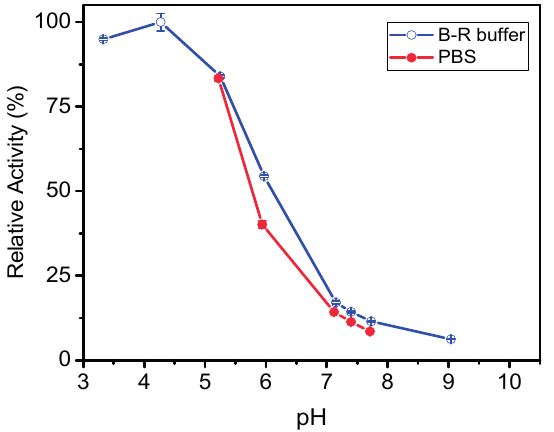
Figure 2. Relative activity of β -galactosidase as a function of pH in Britton-Robinson (B-R) and phosphate (PBS) buffers. The enzyme activity was assessed by applying the correction for absorbance (420 nm) resulting from the effect of pH on the extinction coefficient of ONP (see Figure 1b). Activity in pH 7.15 B-R buffer is used as reference. Lines are shown as visual